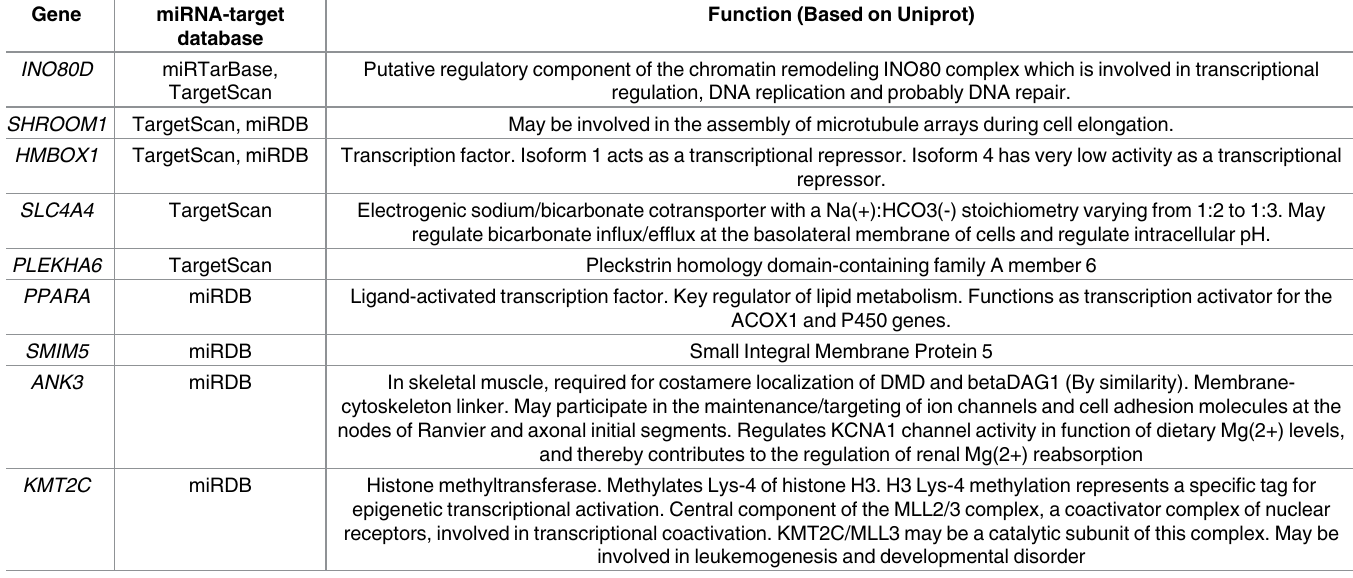
Table 4. Targets of miR-200b-3p that are downregulated in UC patients with neoplasia compared to UC patients. Gene